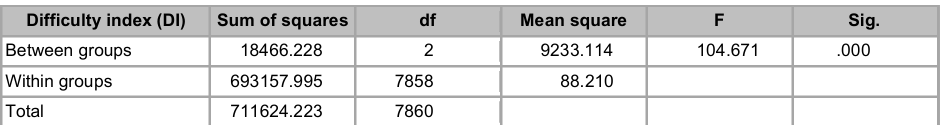
One-way analysis of variance (ANOVA)